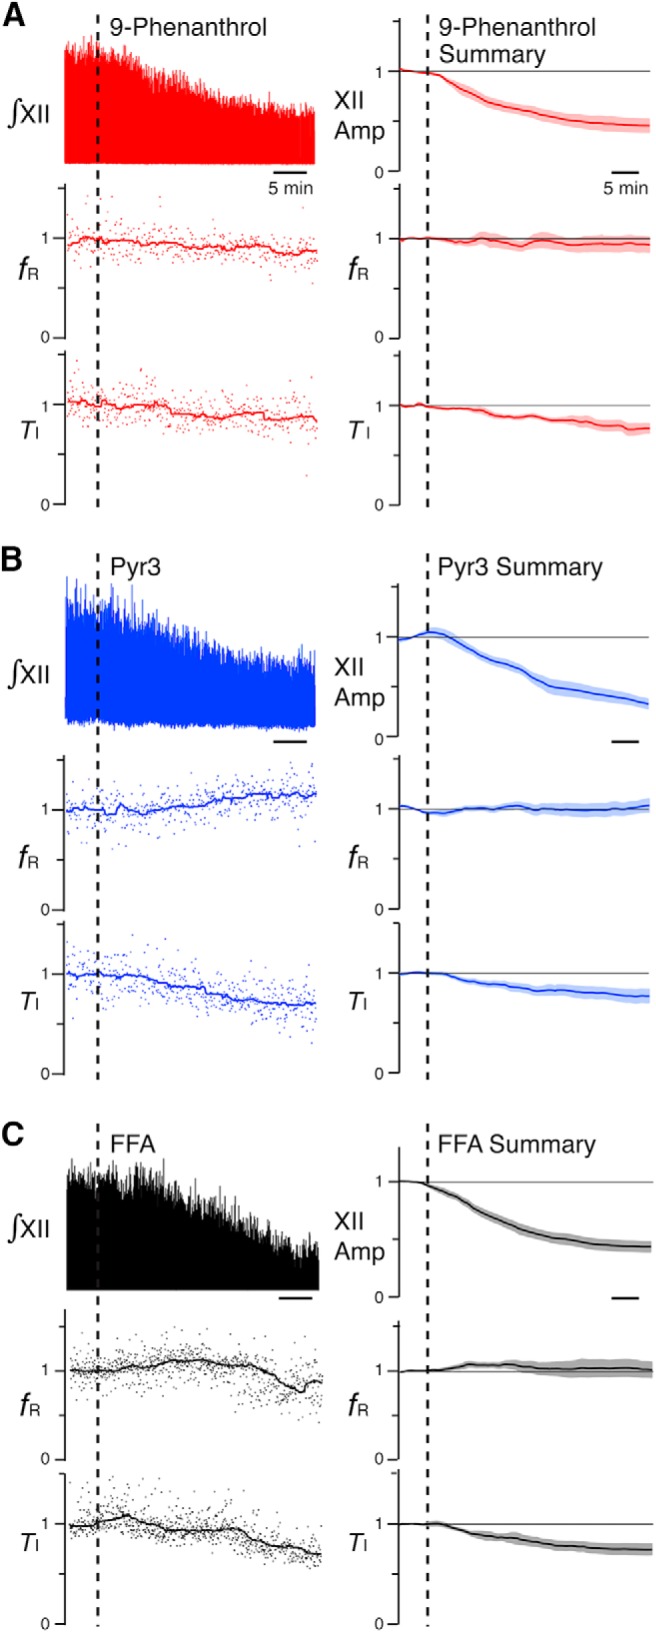
Effects of TRPM4, TRPC3, and ICAN channel inhibitors on rhythmic hypoglossal (XII) inspiratory activity in neonatal rat medullary slice preparations in vitro. A–C, Left panels illustrate time courses of integrated XII burst activities (∫ XII), inspiratory frequency (fR), and inspiratory activity time (TI) during application of each inhibitor (A, 50 µm 9-phenanthrol; B, 50 µm Pyr3; C, 50 µm FFA) from representative individual experiments (dots: instantaneous fR and TI; solid lines: running median). Right panels show group summary of mean time course (solid lines) and SEM (light-color bands) of normalized integrated XII amplitude (XII Amp), fR, and TI after drug administration (n = 6 slice preparations each). Time of drug administration is indicated by vertical dashed lines.